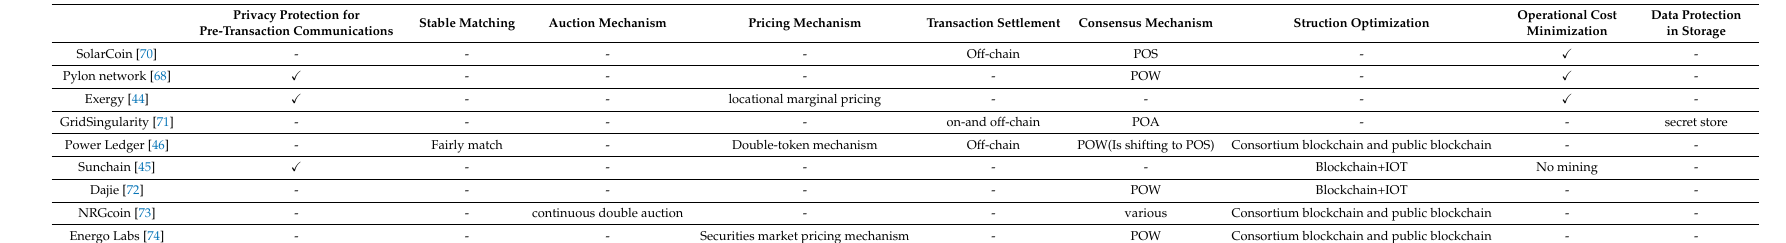
Table 1. Energy project